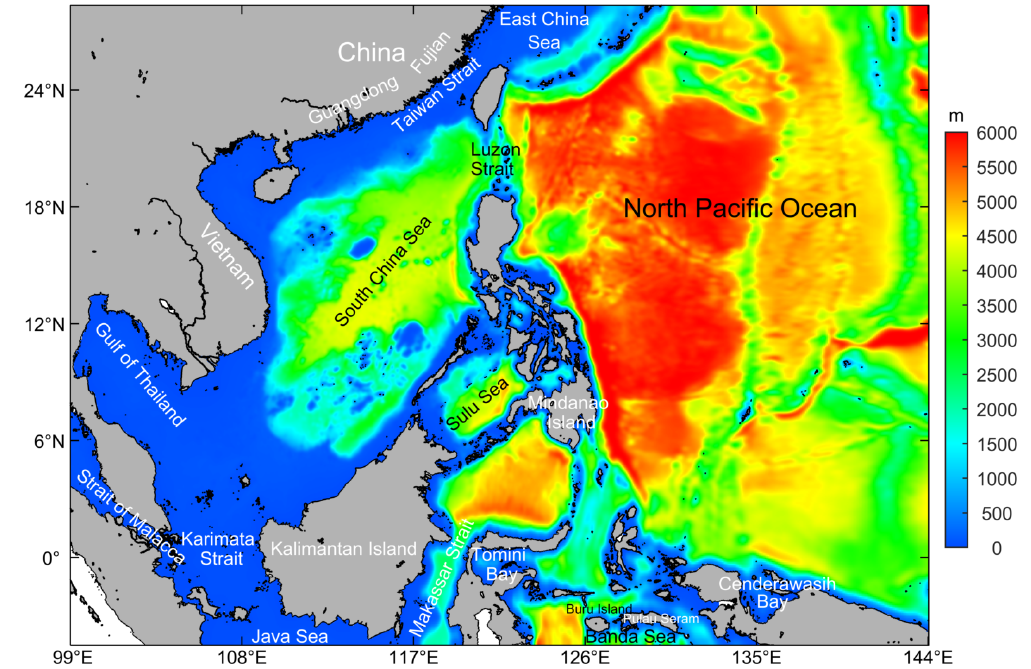
Figure 1. The model domain and bathymetry of